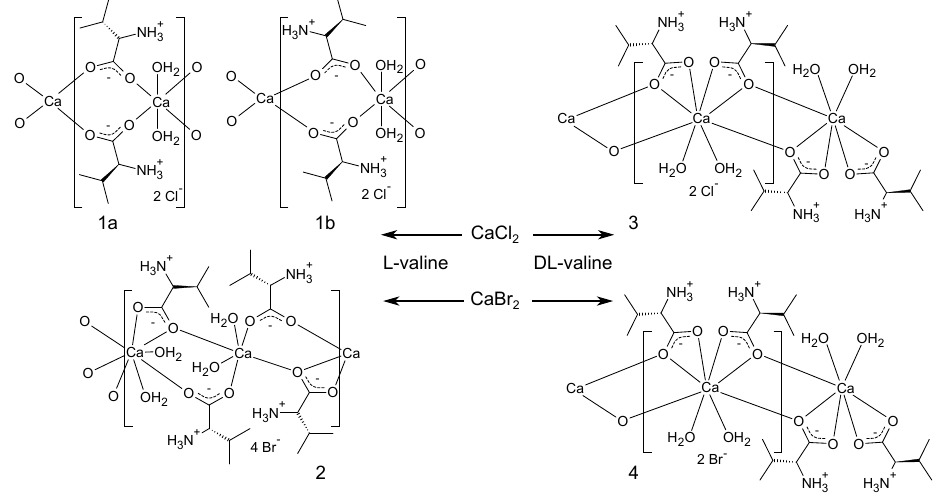
Figure 1. Overview of the performed reactions and reaction